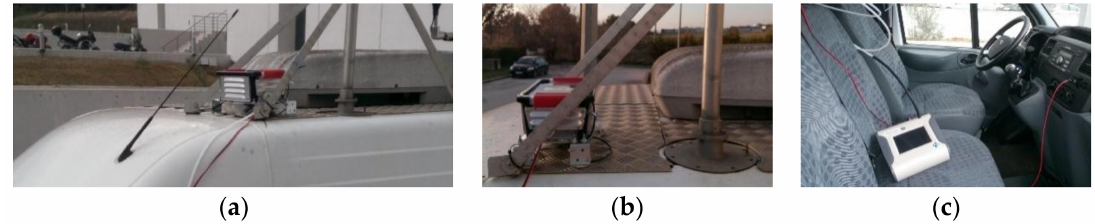
Figure 4. Details of the experimental setup: ( a ) Rooftop installation; ( b ) End of the certified instrument alongside the low-cost air pollution monitoring system (APMS) ensuring common sample air flow; ( c ) Calibrated optical particle counter instrument and power circuit draining voltage from the van